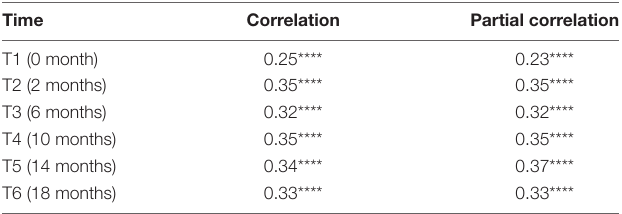
TABLE 1 | Correlations and partial correlations, controlling for age and education, between ISI and CFQ scores. Time Correlation Partial correlation